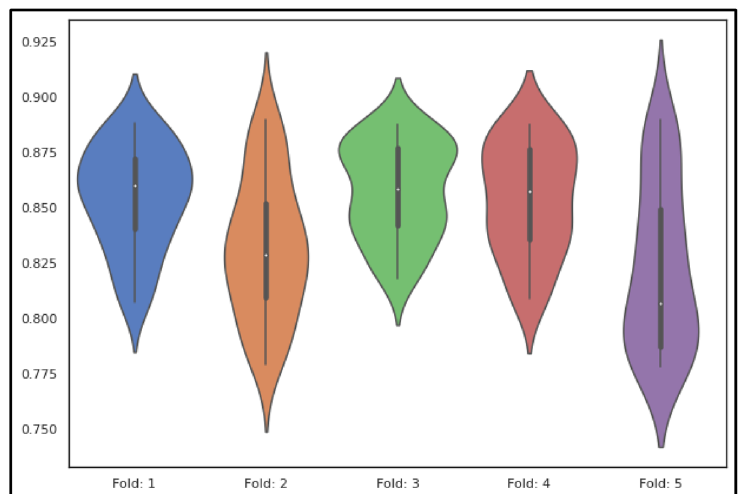
Figure 12. Violinplot of fivefold cross validation for enhancers (random forest).